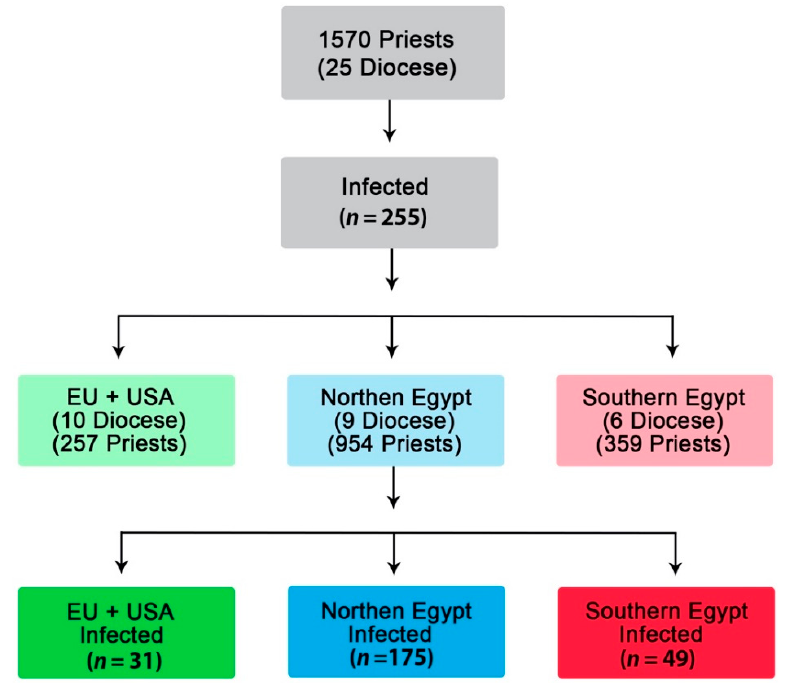
Figure 1. Flow chart of participants.